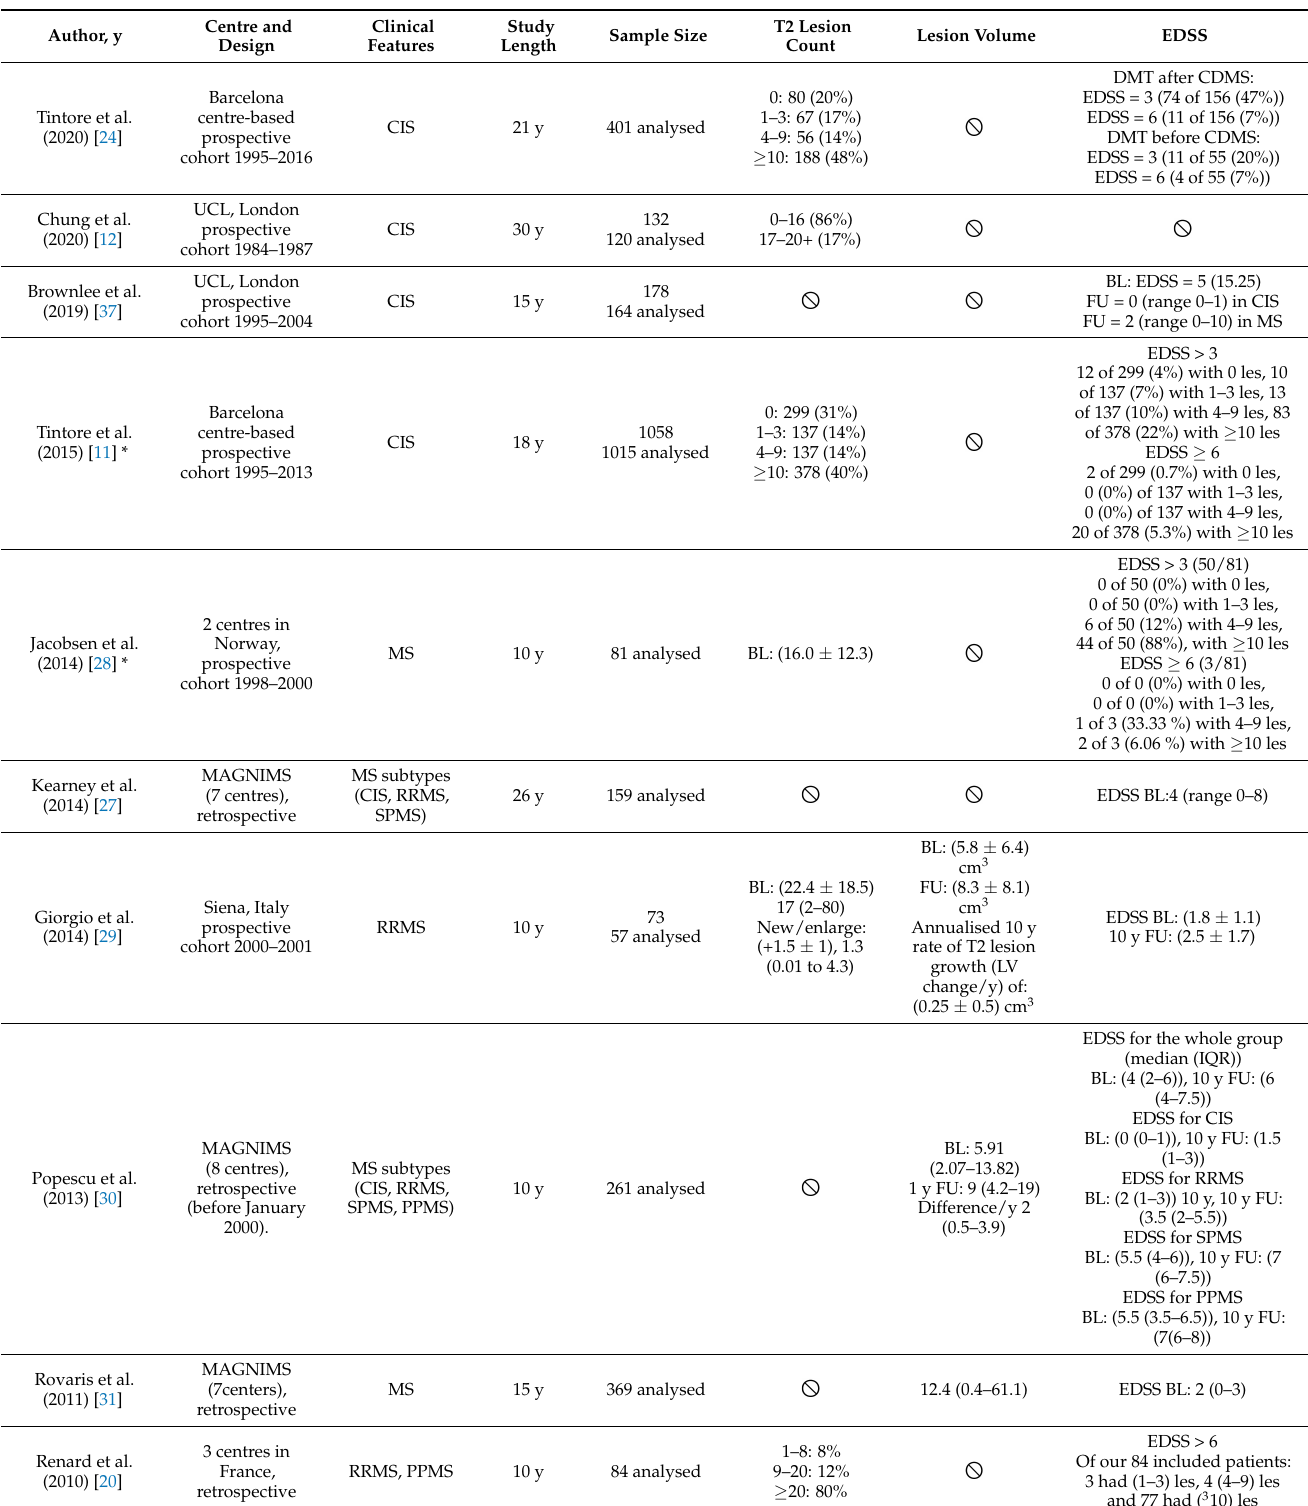
Table 2. Characteristics of the included studies (qualitative and